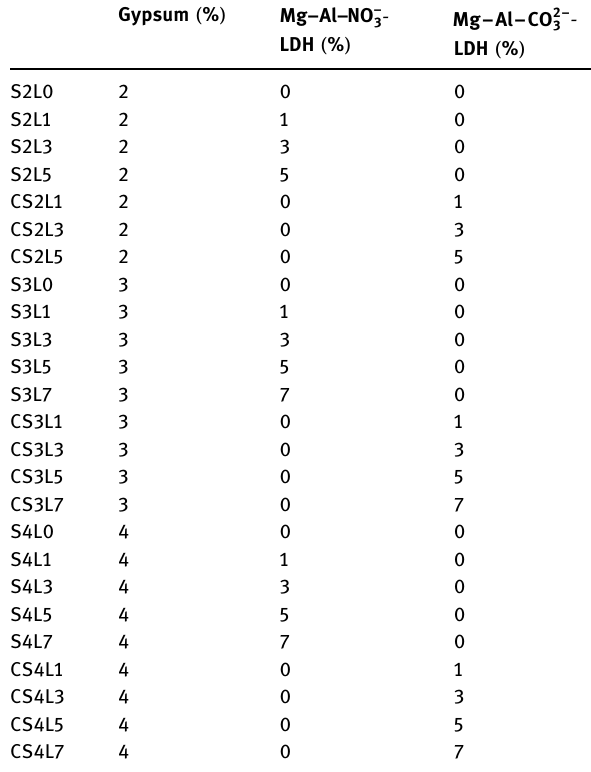
Table 1: Cement paste mix ratio design ( %